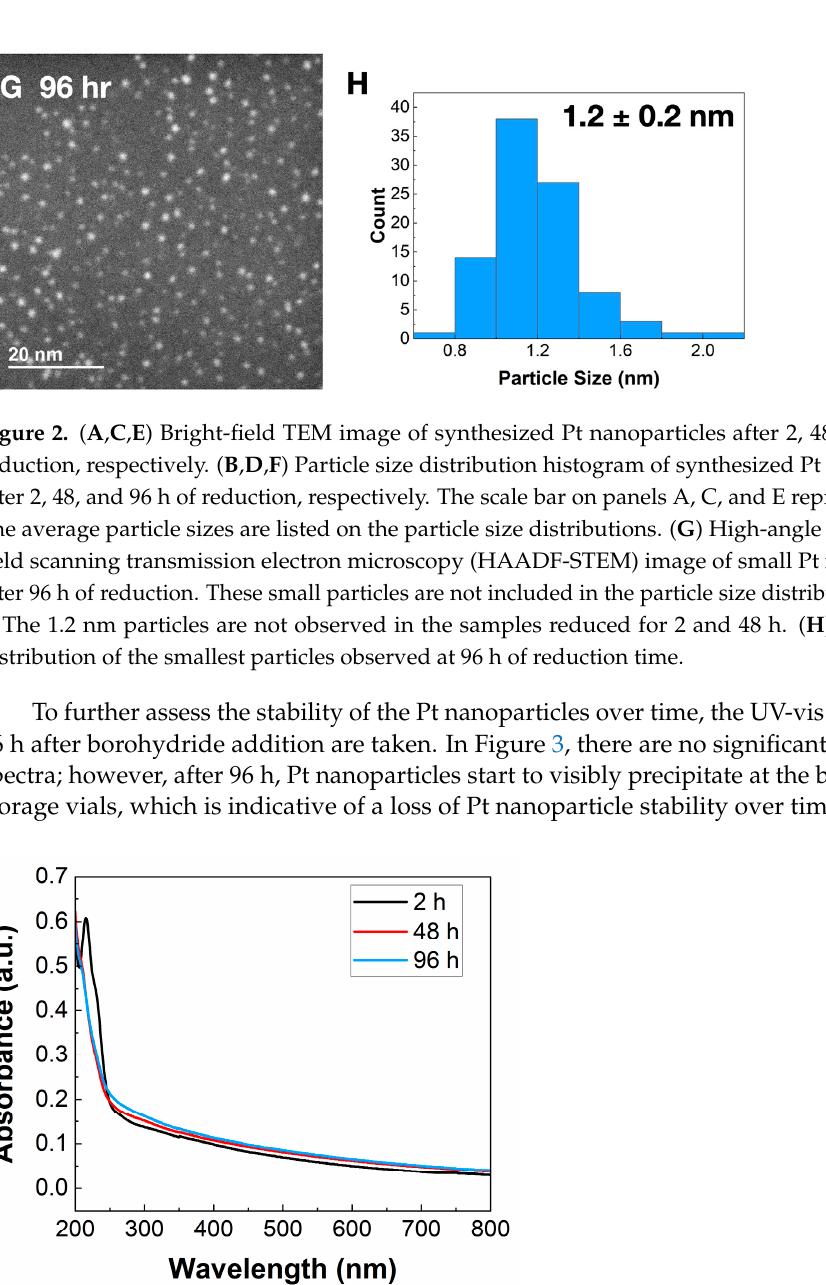
Figure 3. UV-vis spectra of Pt nanoparticles in aqueous solution at 2 h (black), 48 h (red), and 96 h (blue) after adding sodium borohydride.